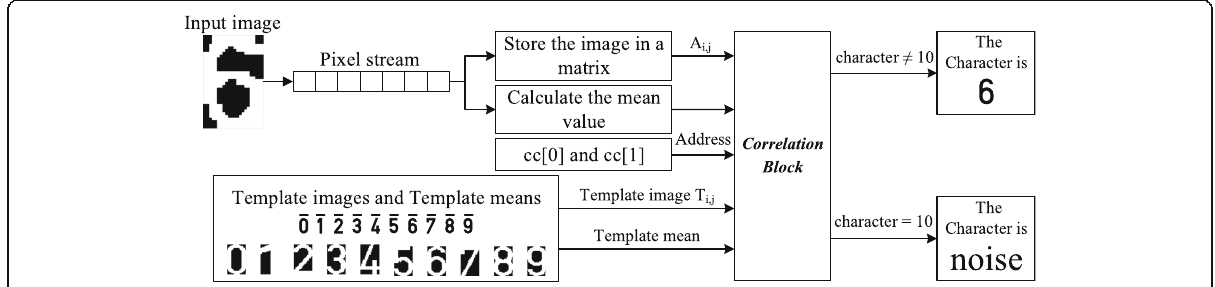
Fig. 9 Second approach OCR hardware implementation block diagram